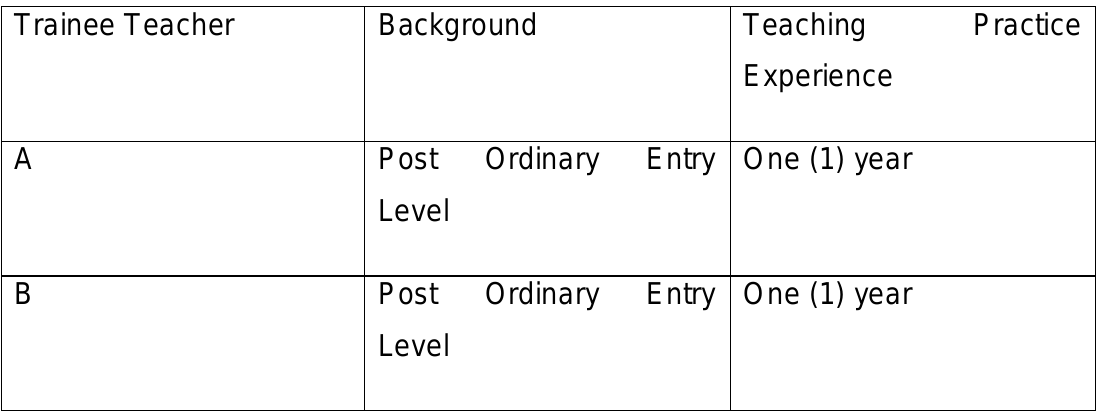
TABLE 4.2. INFORMATION OF TRAINEE